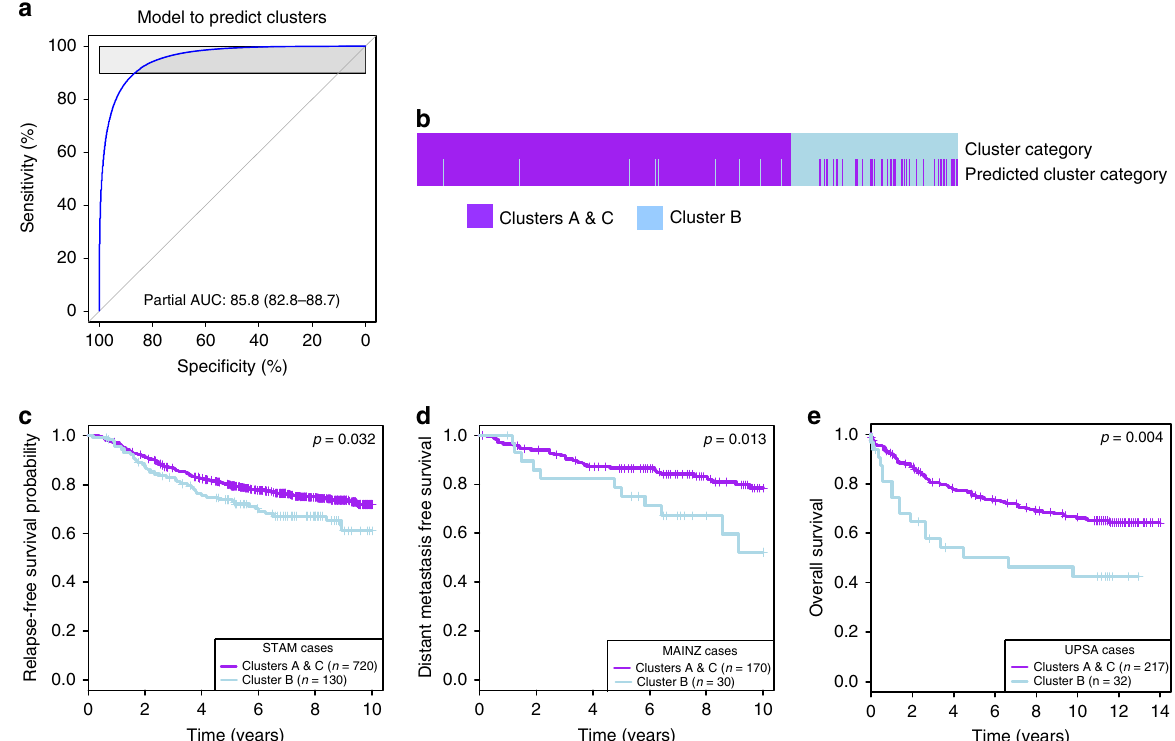
Fig. 3 Prediction of Cluster B using binomial logistic regression. a Using binomial logistic regression penalized by the lasso method, we trained on 4546 samples to predict Cluster B. ROC curve assesses how the lasso output (the weighted gene sets in Supplementary Data 1) discriminates a sample to be Cluster B or not. b For the 4546 samples in the training set, the heatmap represents whether a sample is part of Cluster B (light blue) or Clusters A and C (purple), using the clustering or the lasso methods. c – e The prediction of the clusters (lasso) was tested on fi ve cohorts, which were not included in the training phase: c STAM ( n = 856), d MAINZ ( n = 200), and e UPSA ( n = 289) are presented here, the two other cohorts CAL and PNC are presented in Supplementary Figures. The association between predicted clusters and survival was tested using Kaplan – Meier survival curves for predicted Cluster B (light blue) and predicted Clusters A and C (purple). p values are from log-rank tests. Kaplan – Meier display relapse-free survival for STAM, distant metastasis-free survival for MAINZ, and overall survival for